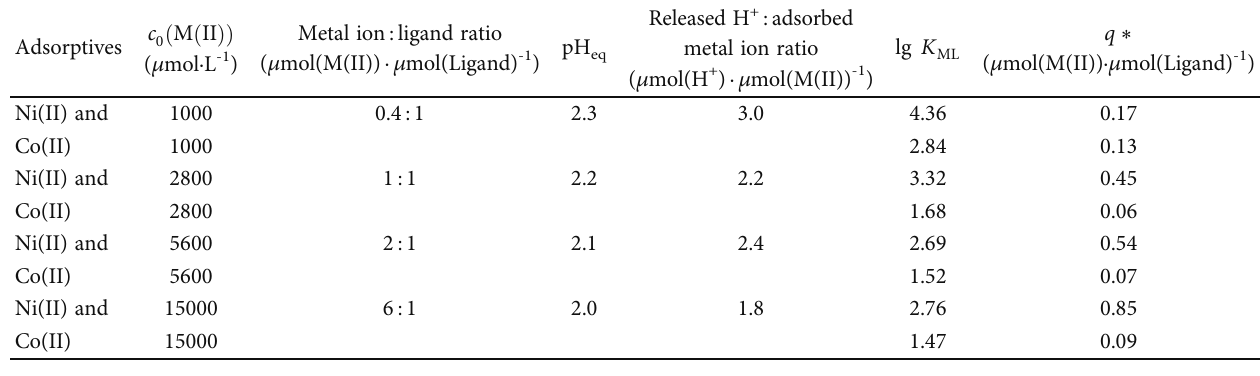
, and molar equilibrium ML